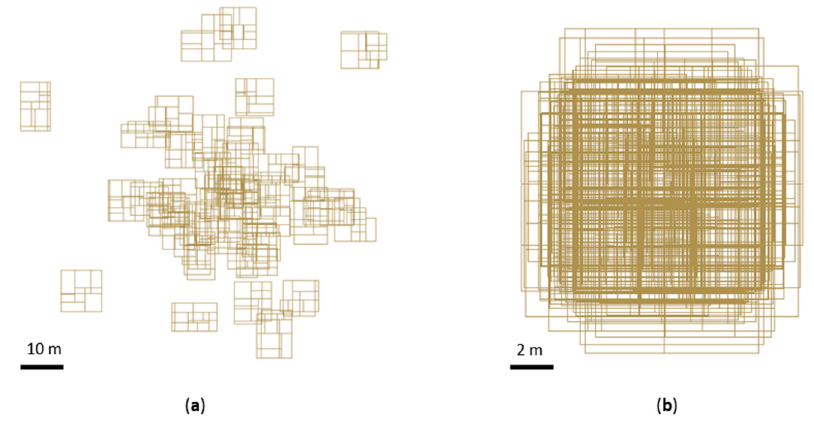
Figure 6. ( a ) Original placement of generated 3D building models; ( b ) the same models after their placement to the local coordinate system origin.